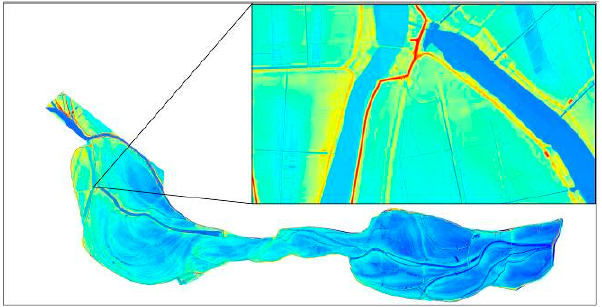
Figure 3. Example of high-resolution DEM data.